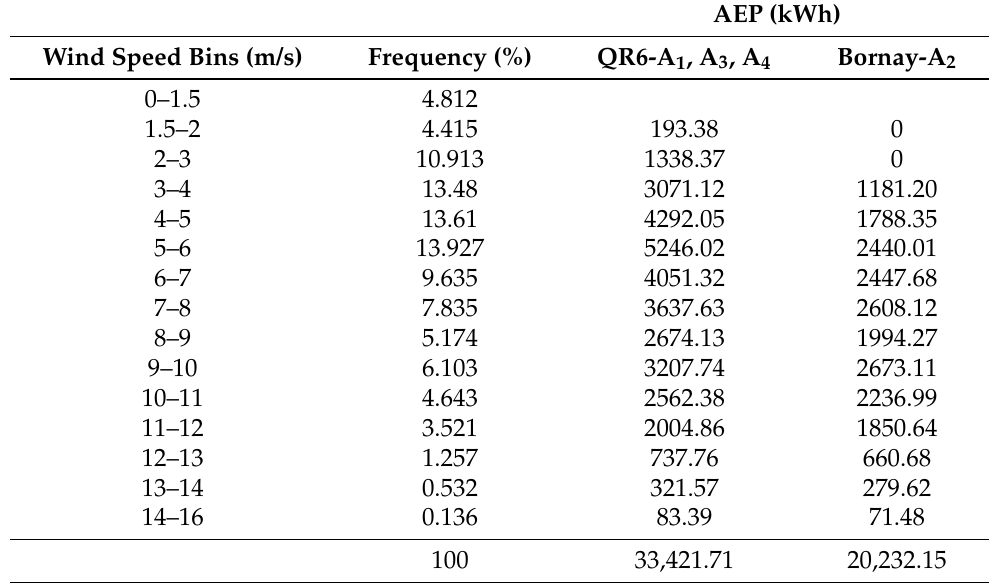
Table 7. AEP of a single turbine for individual wind speed bins (‘alone near buildings’